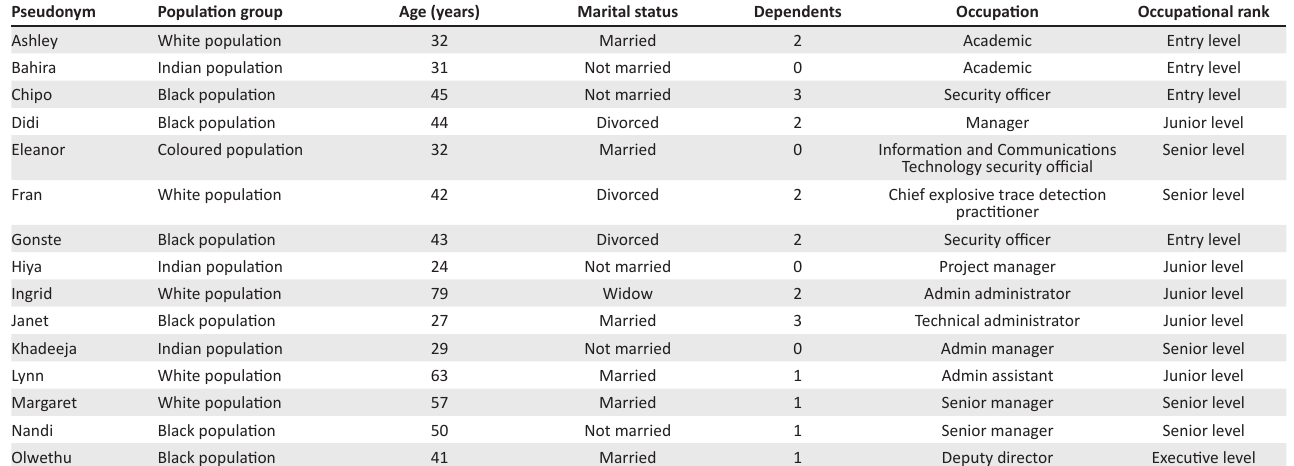
TABLE 1: Demographic profile of